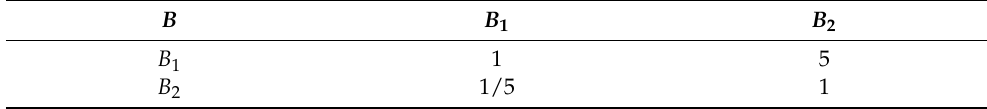
Table 8. Judgment matrix of geological condition